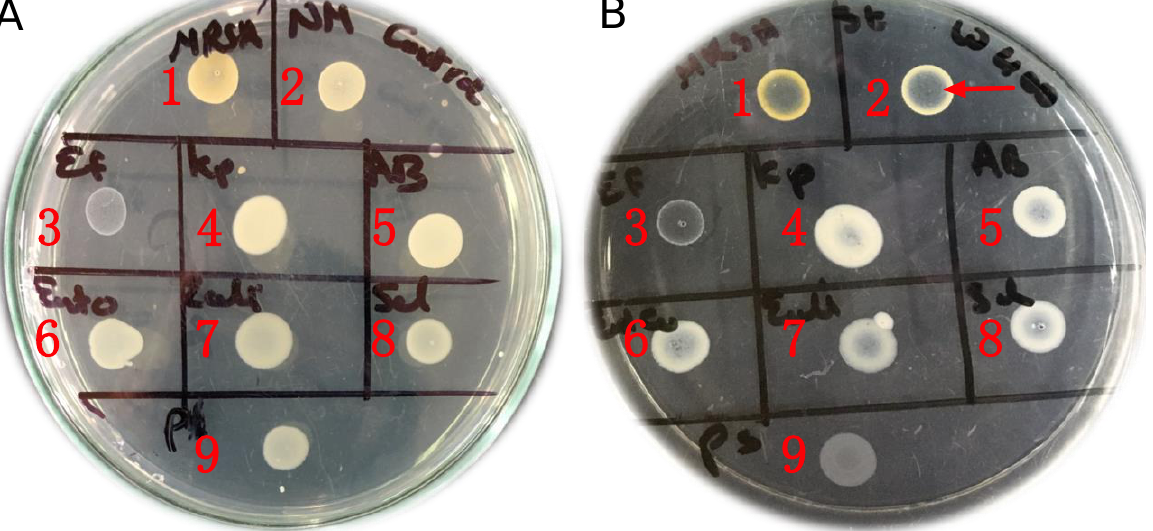
Figure 2. Vapor-phase minimum inhibitory concentration assay (VP-MIC). ( A ) Photo of the control plate showing the bacterial growth of the nine selected microorganisms. ( B ) Photo of the sample plate showing inhibition of bacterial growth. The numbers 1–9 on photos ( A ) and ( B ) correspond to the tested microorganisms as follows: 1. Methicillin-resistant Staphylococcus aureus (MRSA USA300), 2. Staphylococcus aureus Newman, 3. Enterococcus faecalis ATCC19433, 4. Klebsiella pneumoniae ATCC13883, 5. Acinetobacter baumannii AB5075, 6. Enterobacter cloacae , 7. Escherichia coli ATCC87, 8.